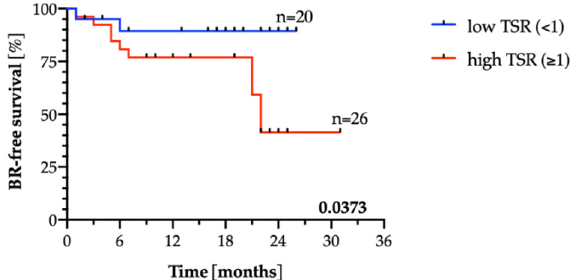
Figure 3. Kaplan–Meier estimates of time to biochemical recurrence (BR) in the pilot cohort ( n = 72). Note that not all patients are included in Kaplan–Meier analysis as the exact timepoints of BR oc- currence for some patients were